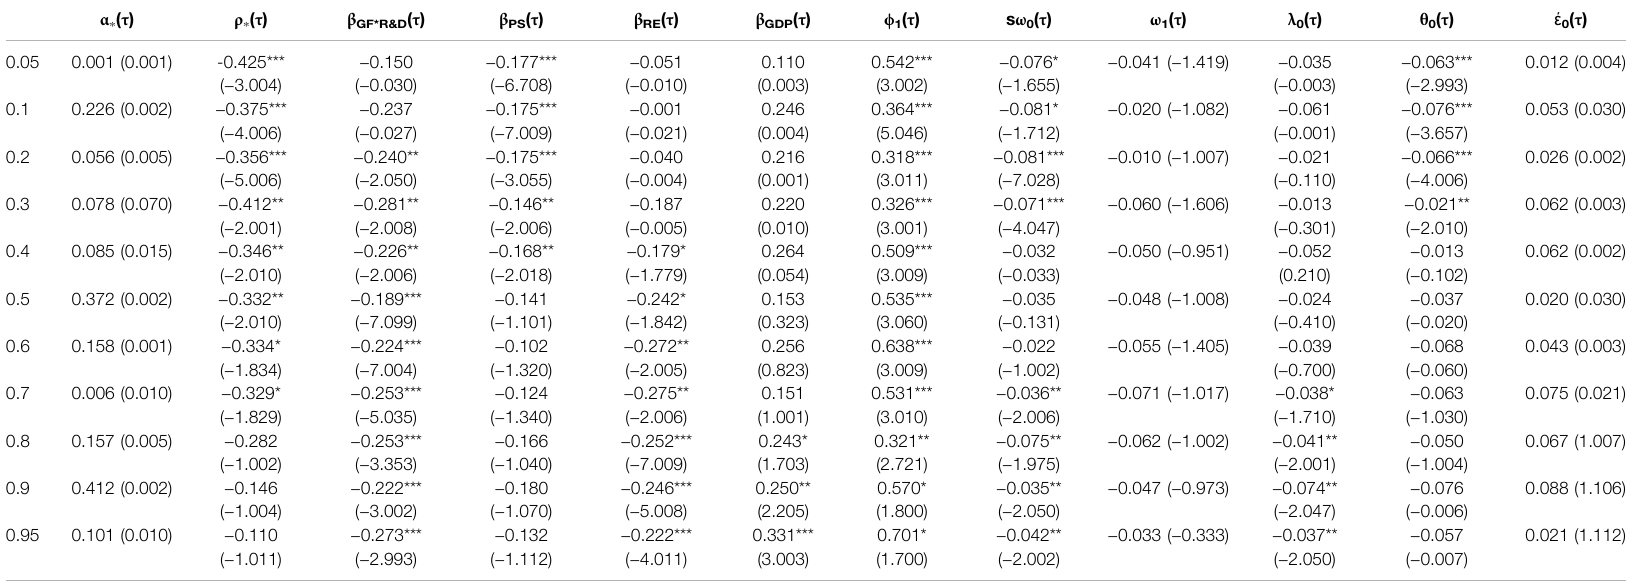
TABLE 5 | R&D impact on sustainable